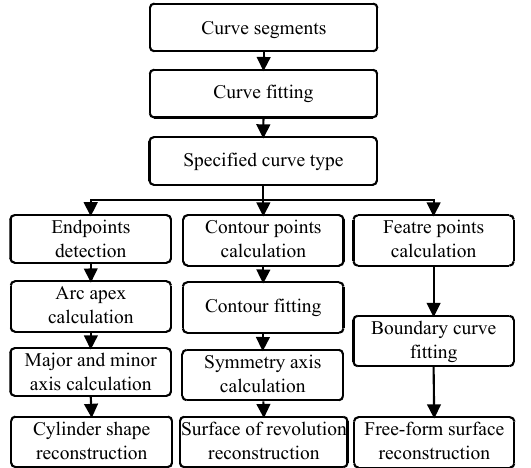
Figure 7. Reconstructing computer simulated geometric structure model. (a) Feature lines extraction in ρ - θ space (b)